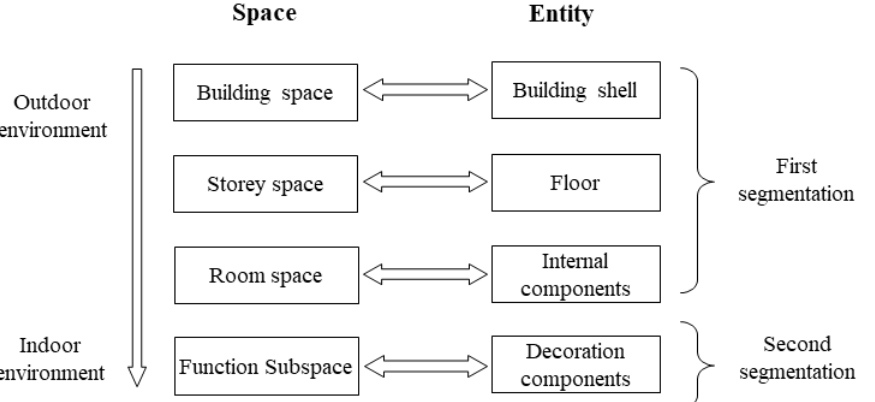
Figure 1. Indoor space and segmentation components.